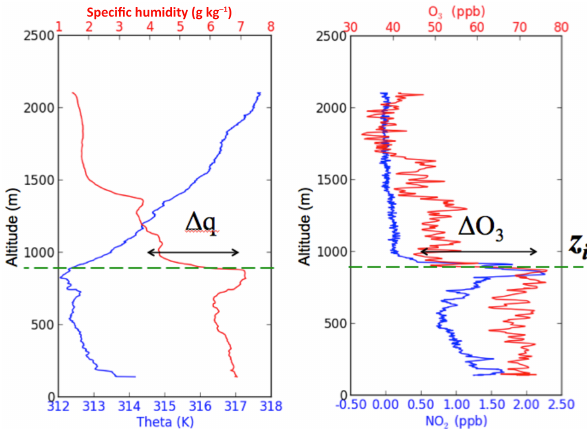
Figure 8. Example of vertical profiles of potential temperature (theta) and specific humidity ( q ) on the left, and ozone and NO 2 observed on the right during the flight on 14 August 2013 near Bak- ersfield, CA; z i is the estimated height of the ABL determined by the scalar jump ( (cid:49)q and (cid:49) O 3 shown here) across the entrainment